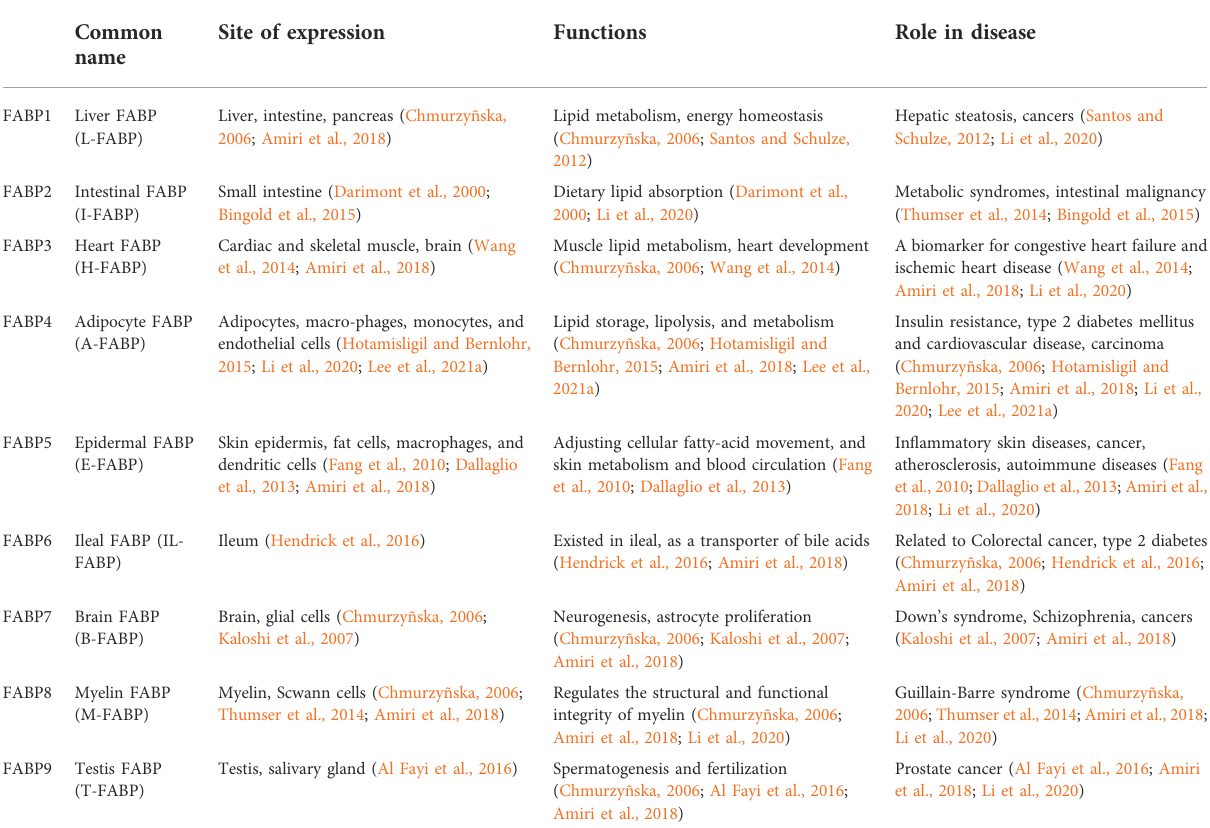
TABLE 1 FABP family members and their